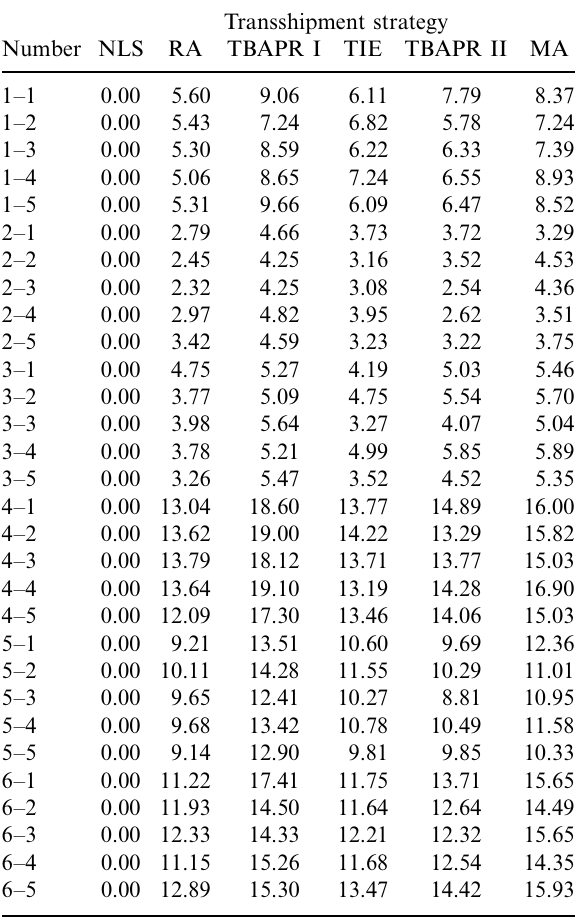
Table 4. Transshipment frequency in the three retailers system Transshipment